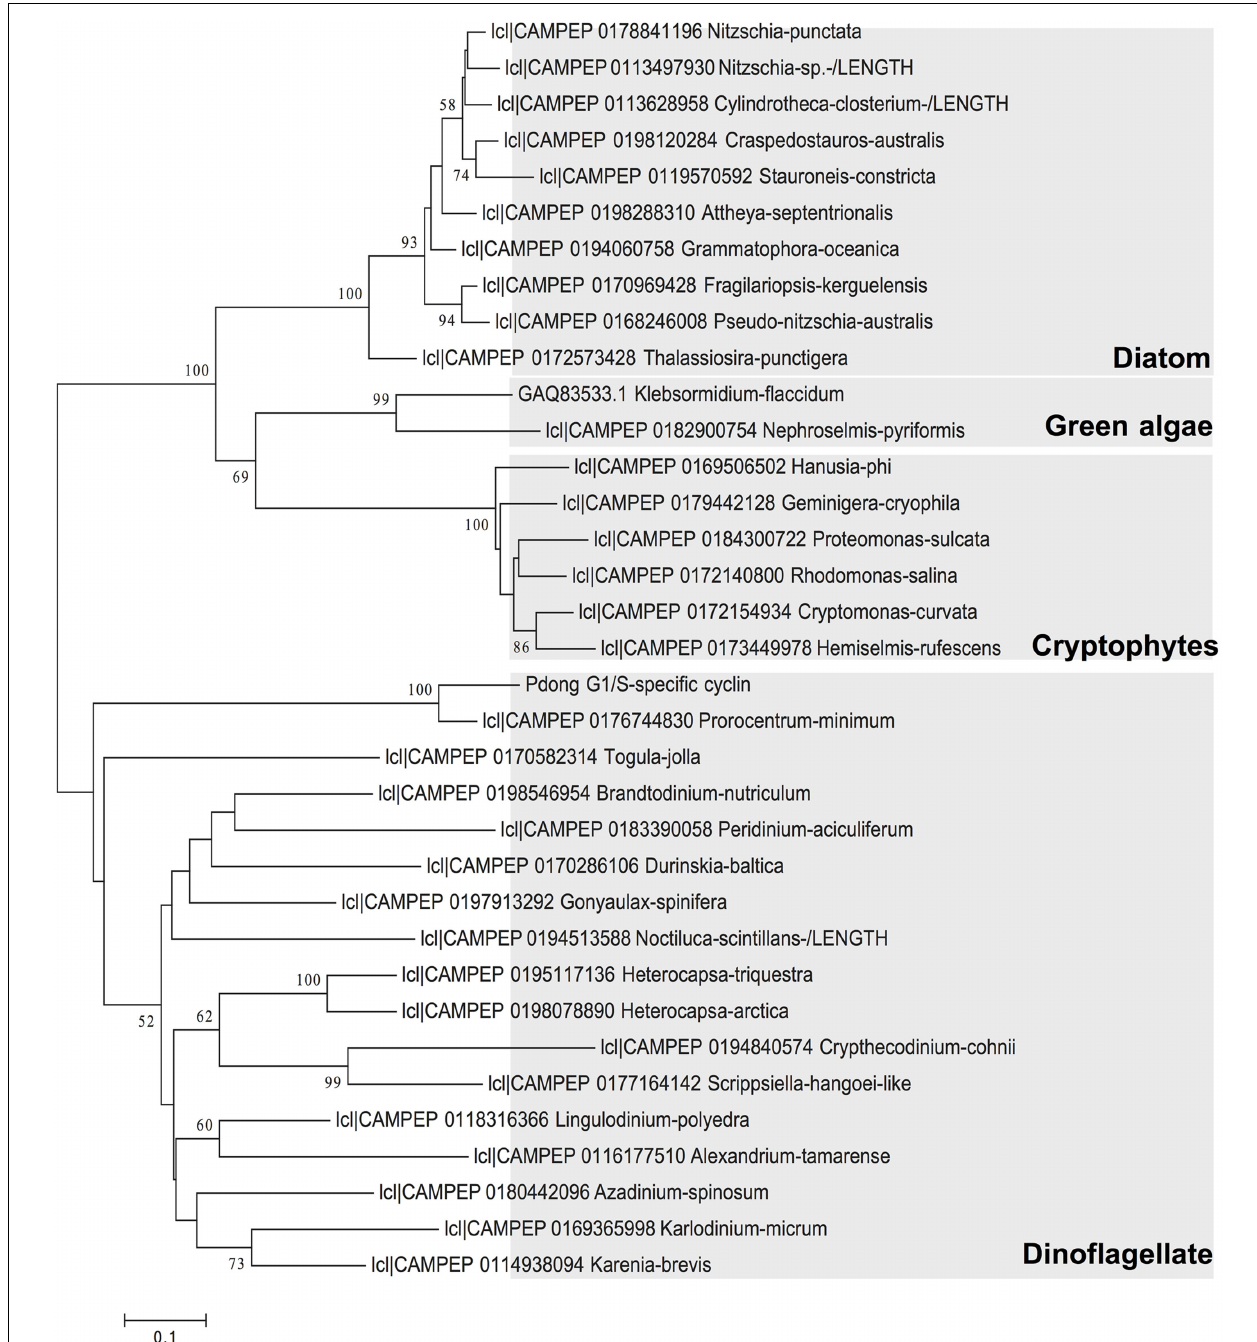
FIGURE 2 | Phylogenetic relationship of P. donghaiense G1/S cyclin gene with this gene in other species based on amino acid sequences. Tree topology shown is from Maximum Likelihood (ML) analysis. Values shown at nodes are NJ bootstrap values of ML analyses (only values > 50% are shown).